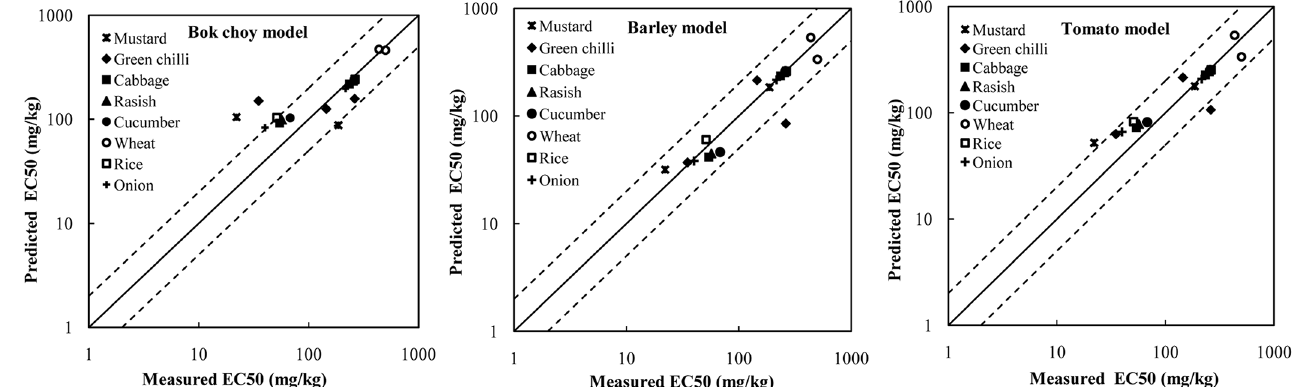
Fig 2. Relativity between the measured and predicted EC50 values of